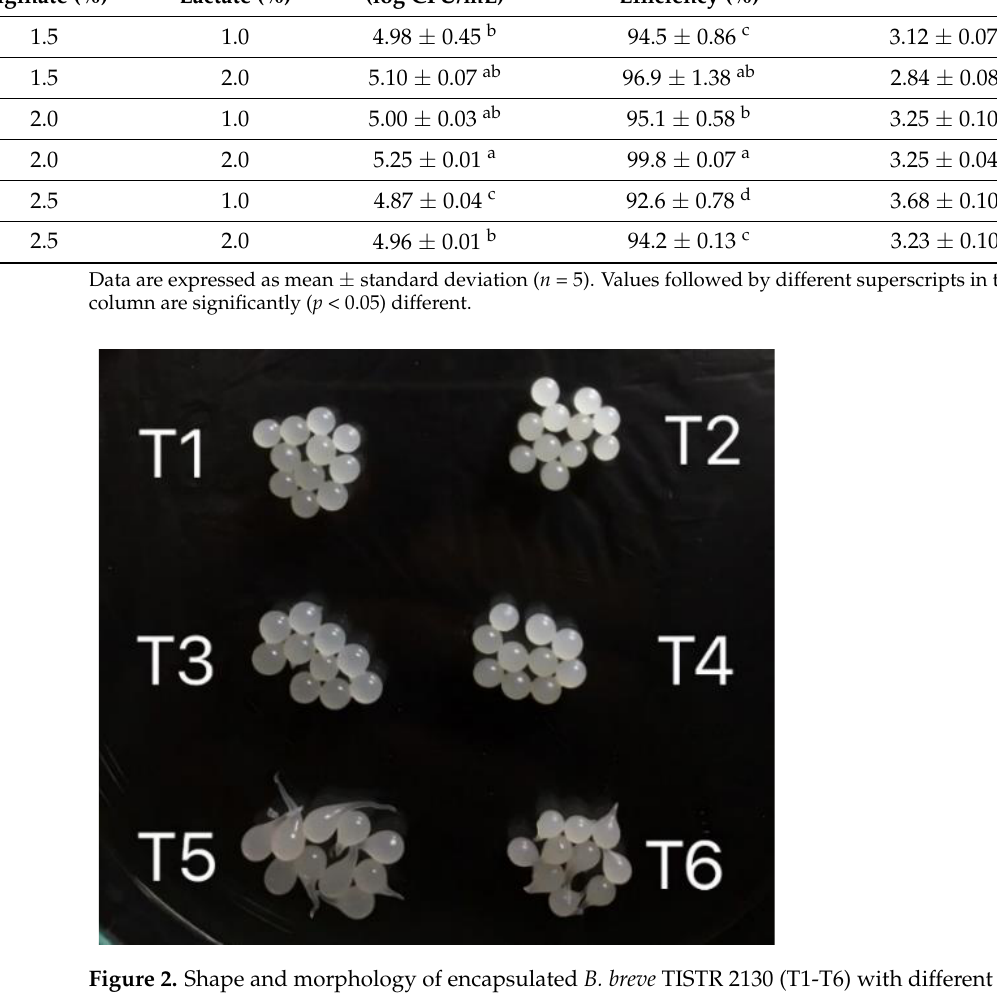
Figure 2. Shape and morphology of encapsulated B. breve TISTR 2130 (T1-T6) with different concen- trations of sodium alginate and calcium lactate (T1: 1.5 and 1.0% w/v ; T2: 1.5 and 2.0% w/v ; T3: 2.0 and 1.0% w/v ; T4: 2.0, and 2.0% w/v , T5: 2.5 and 1.0% w/v ; T6: 2.5 and 2.0% w/v , respectively).